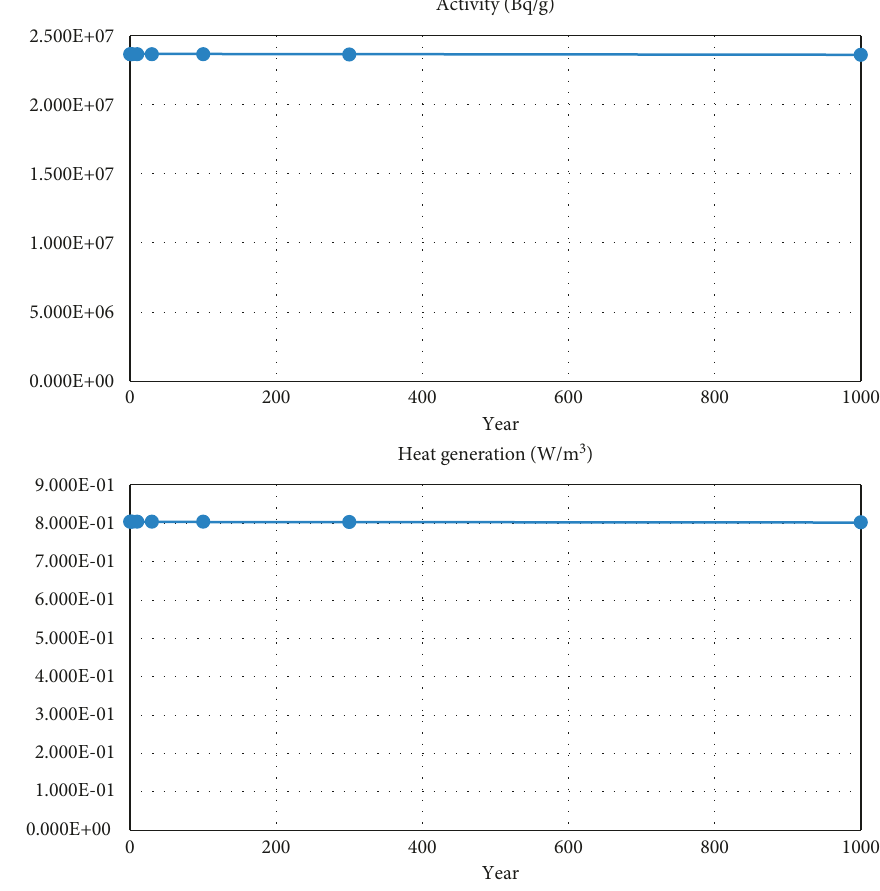
Figure 8: Radiological characteristics of Se waste/waste form. Table 12: Radiological characteristics of Ca(ReO